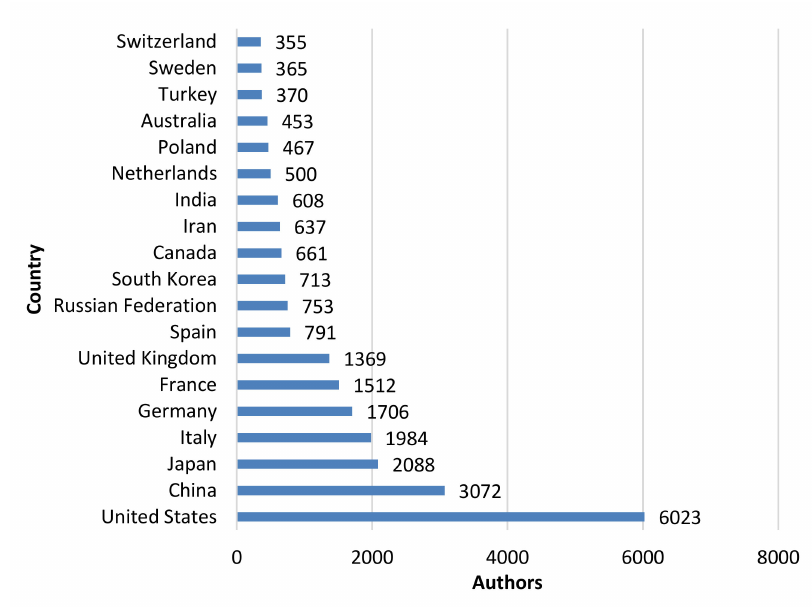
Figure 13. Representation of the 20 countries with the most participating authors.